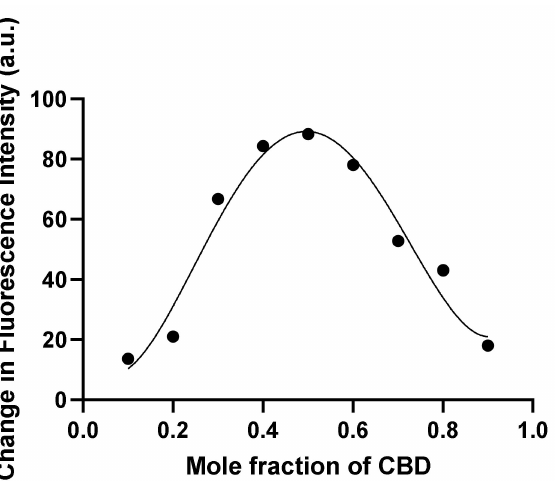
Figure 9. Stoichiometry determination of the predominant complex of tau-CBD. Changes of fluores- cence intensity of a series of protein-ligand mixtures were measured. The total molar concentration of CBD and tau was constant (20 µ M) but their mole fractions were